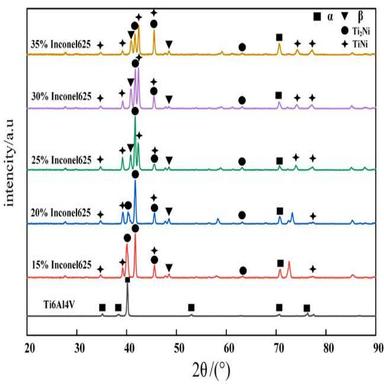
XRD analysis results of different layer materials.